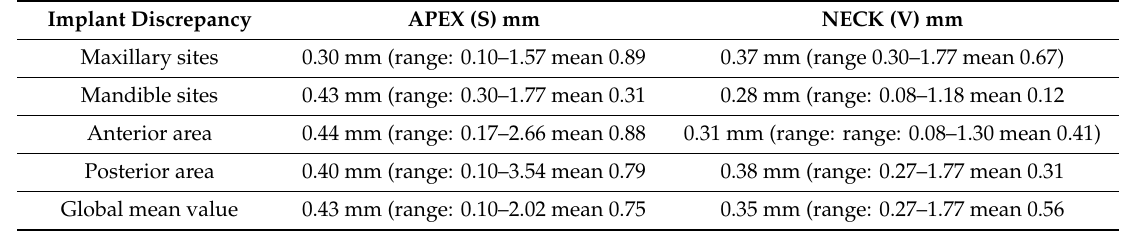
Table 2. The horizontal apex (S) and neck (V) implant discrepancies.